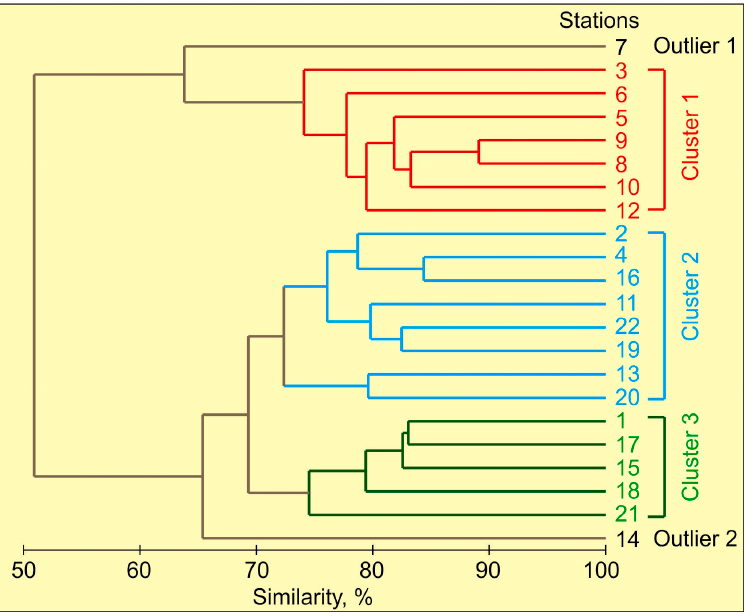
Figure 5. Dendrogram resulting from clustering performed on the Bray–Curtis similarity matrix (group-average method) created from the square-root-transformed copepod data collected in the south-eastern Barents Sea in summer 2012.